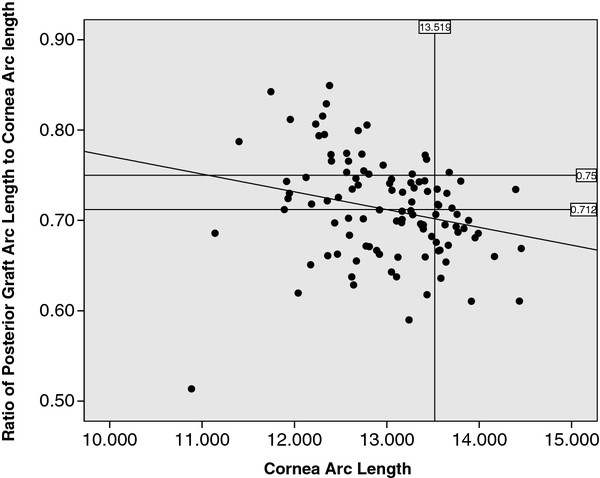
Graph of Ratio of posterior graft arc length to posterior cornea arc length vs cornea arc length. Vertical line represents the 75th percentile of posterior cornea arc length (13.52mm). Horizontal line represents the mean ratio of graft posterior arc length to posterior cornea arc length (0.71).